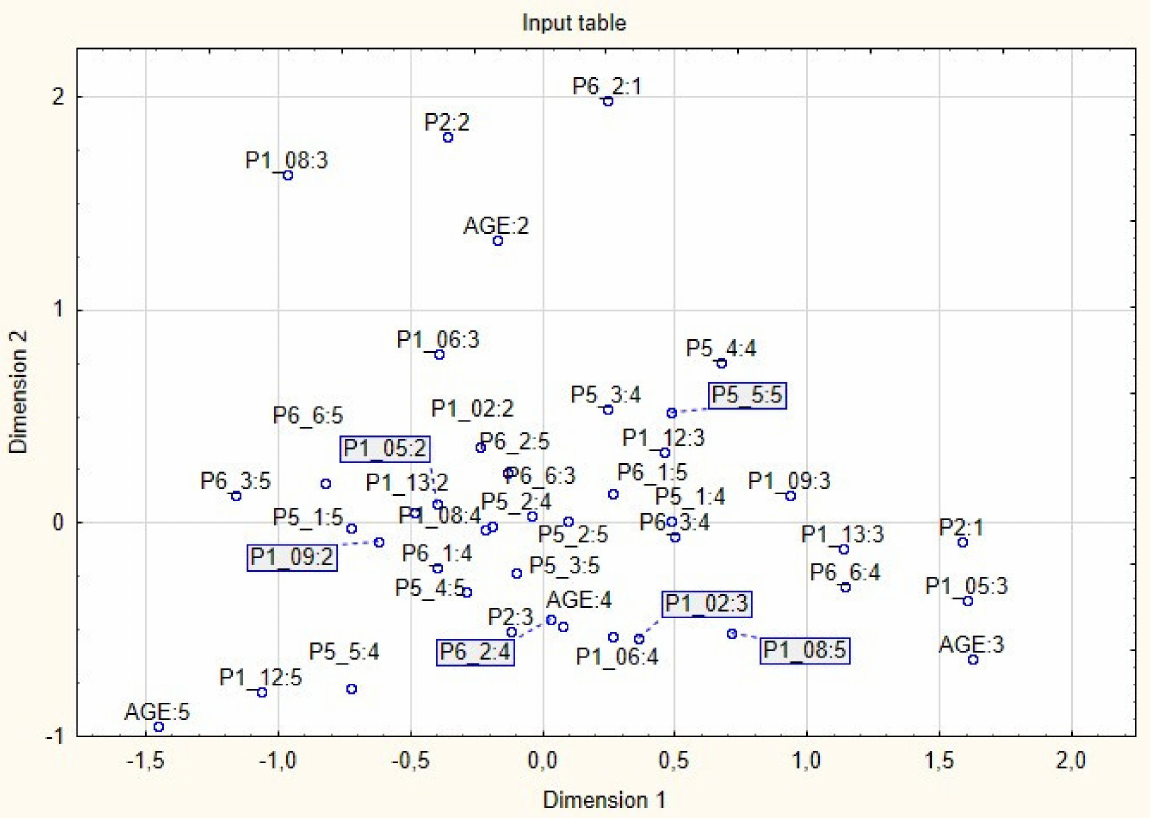
Figure 2. Two-dimensional perception map for the variables age and subjective salary evaluation in energy